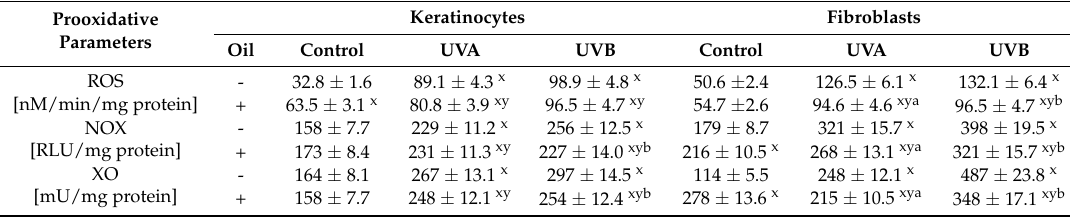
Table 2. The reactive oxygen species (ROS) generation, xanthine oxidase and NADPH oxidase activity in keratinocytes and fibroblasts after exposure to UVA (30 J/cm 2 and 20 J/cm 2 ) and UVB radiation (60 mJ/cm 2 and 200 mJ/cm 2 , respectively) and sea buckthorn seeds oil (500 ng/mL)